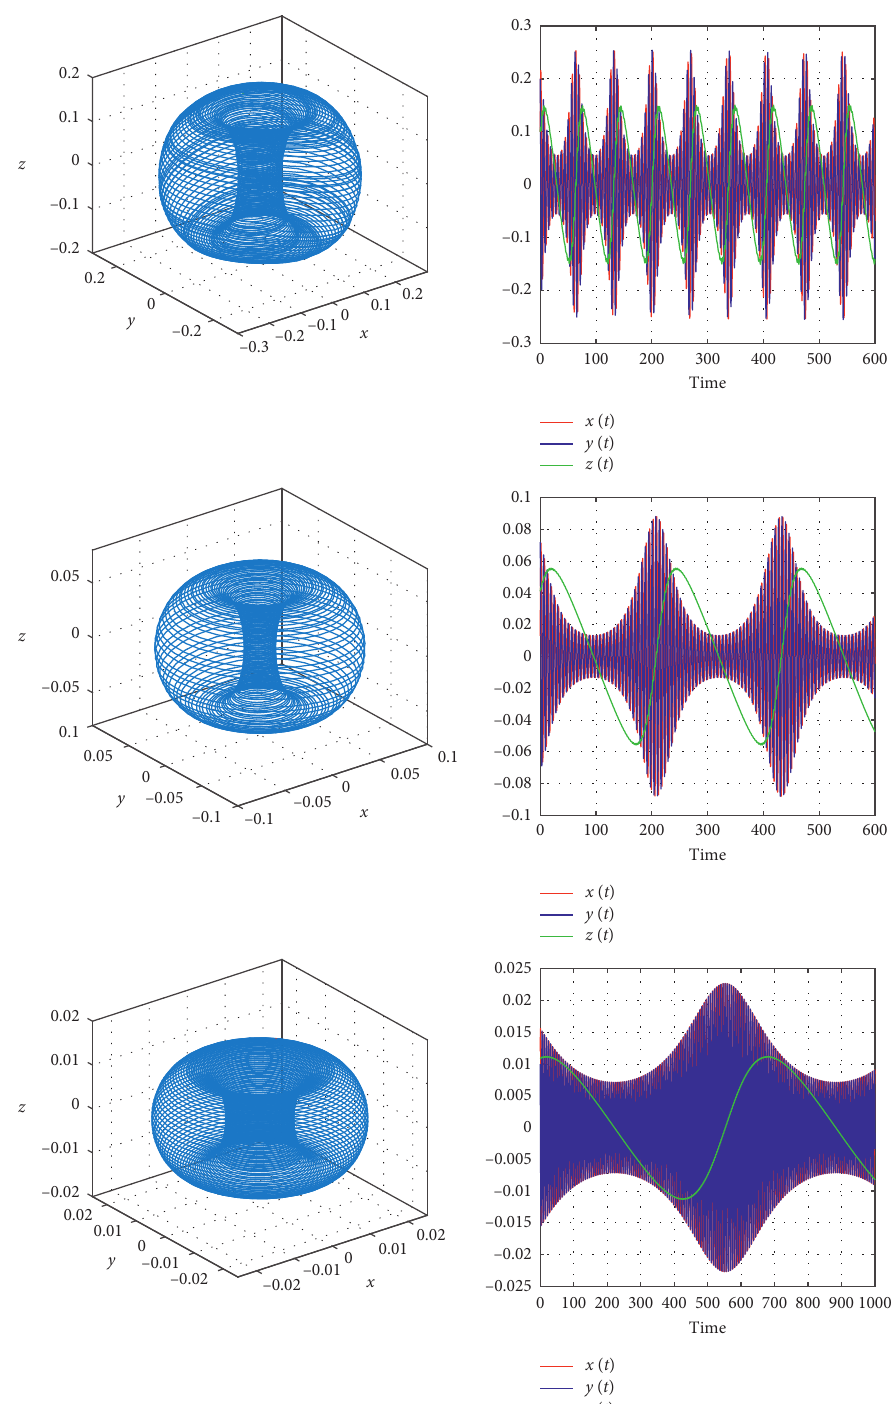
Figure 2: Quasiperiodic orbits of system (3) near the origin and their xyz -coordinates in function of the time t for a � 10 − 2 , a � 10 − 3 , and a � 10 − 4 ,